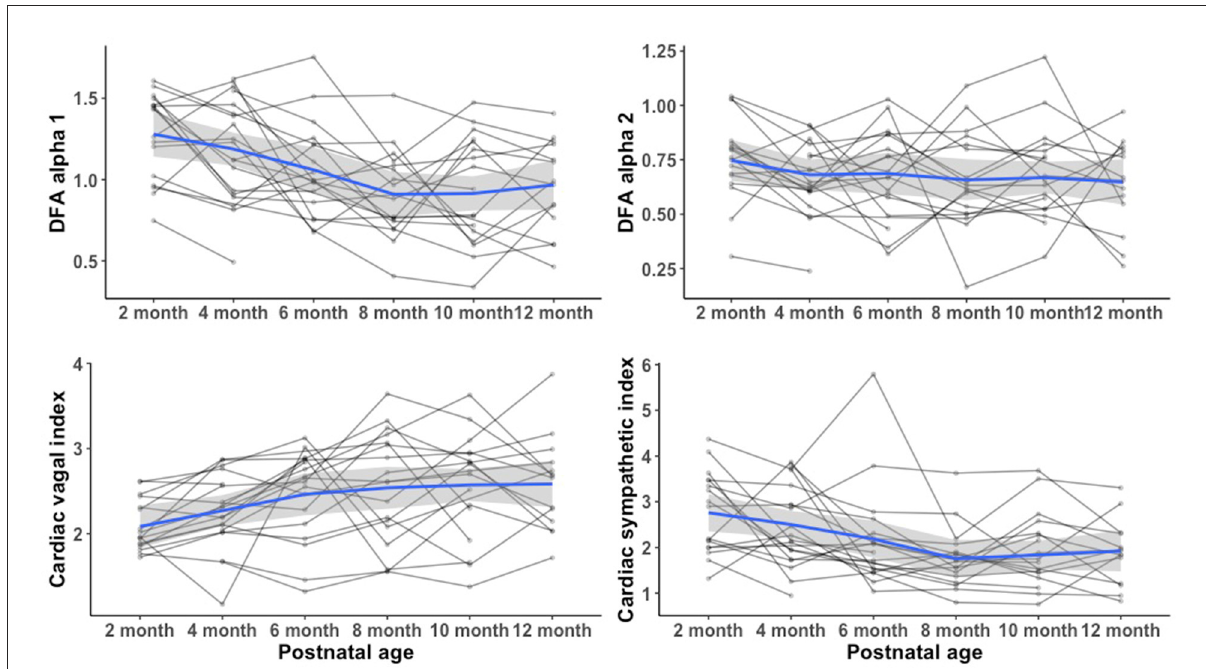
FIGURE3 Heart rate variability trajectory at 1 year of age in infants with IESS. There was a trend toward an increase in mean CVI values at consecutive visits until the postnatal age of 8 months after which there was a plateau. There was also a simultaneous decrease in CSI and DFA α 1, which also